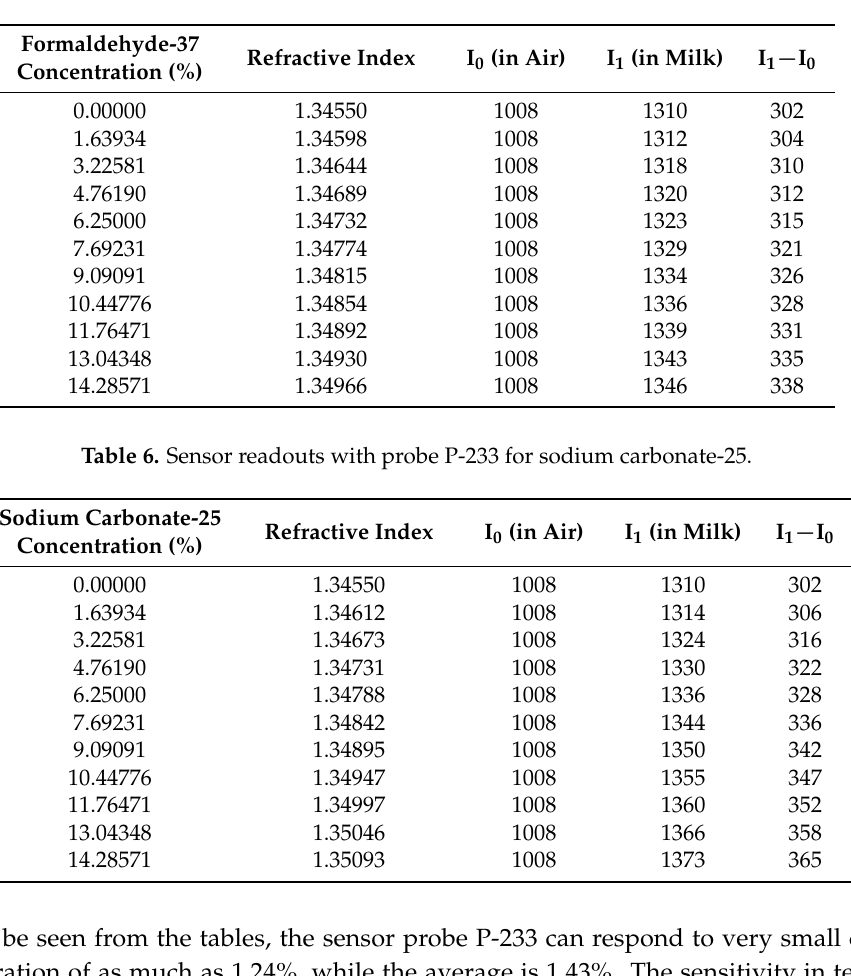
Table 5. Sensor readouts with probe P-233 for formaldehyde-37.